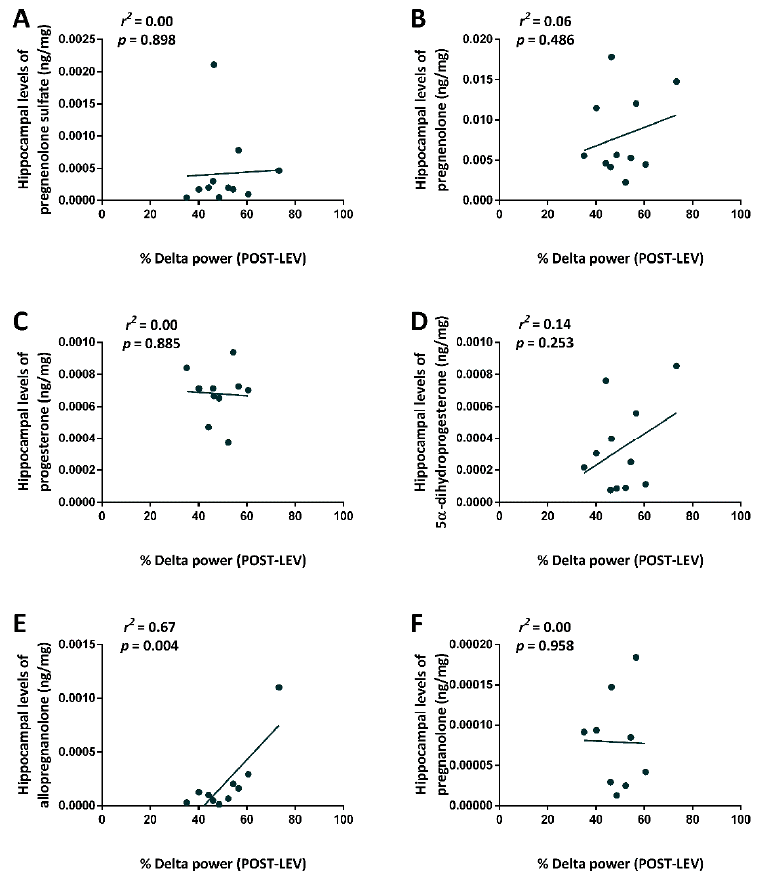
Figure 7. Relationship ( r 2 ) between the frontal power band spectrum (% Delta power) in the post- treatment interval and the hippocampal neurosteroid levels measured after treatment with levetiracetam (LEV), 2 weeks after treatment. Statistical analysis was performed using a linear regression analysis, with neurosteroid levels as dependent variable and the frontal power band spectrum as independent variable ( A – F ). POST-, after minipump implantation.